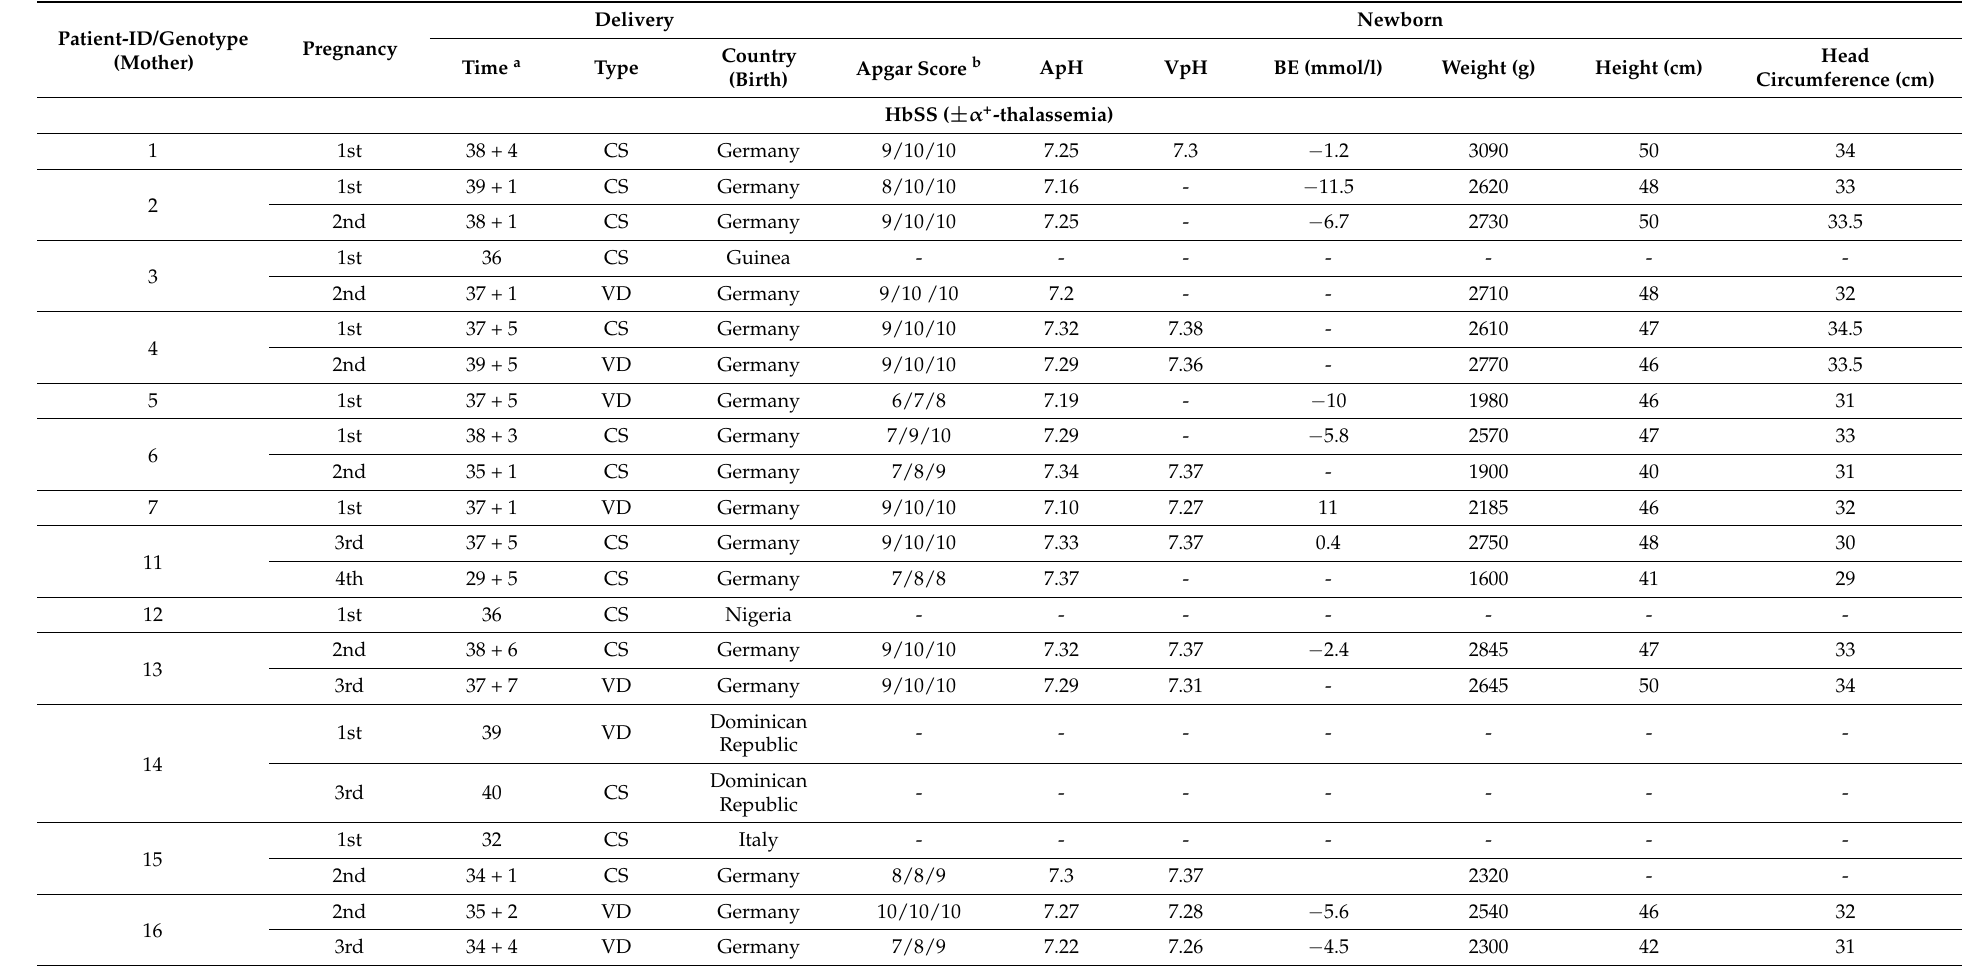
Table 2. Delivery and neonatal status in women with SCD (N =